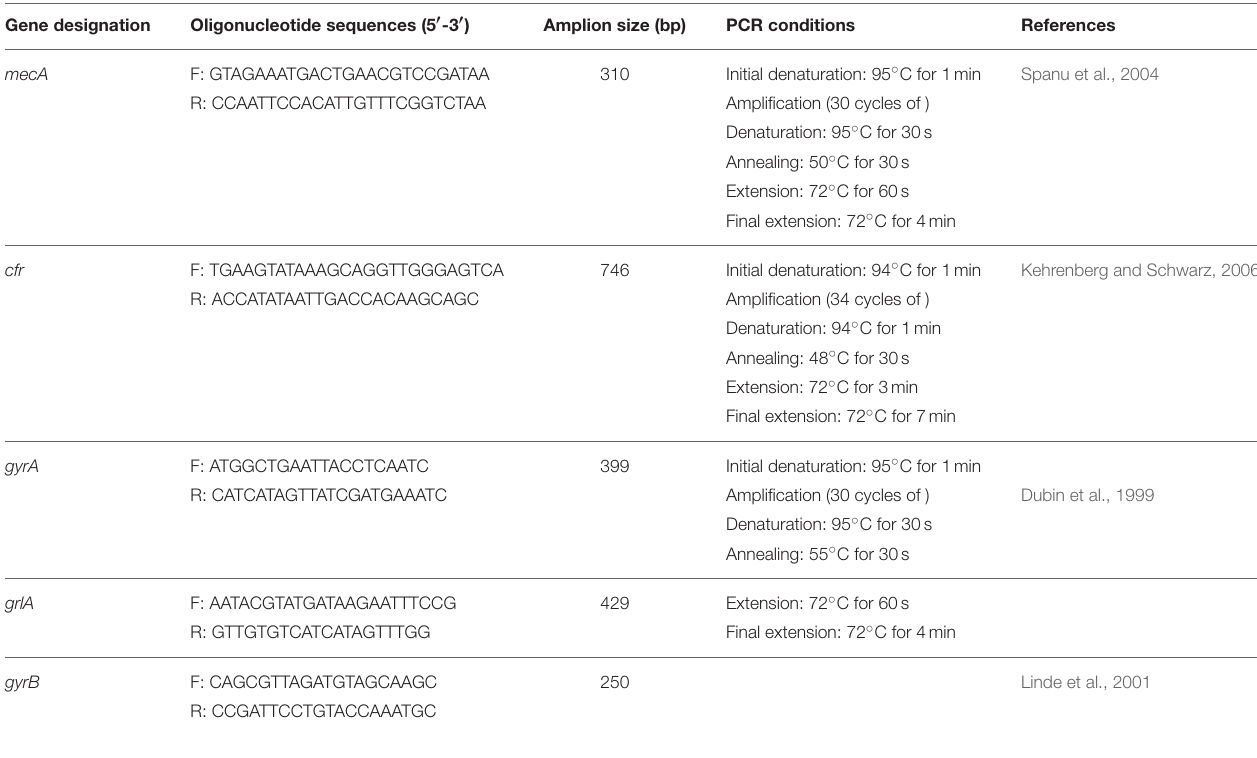
TABLE 1 | Antimicrobial resistance genes targets, primers, and nucleotide